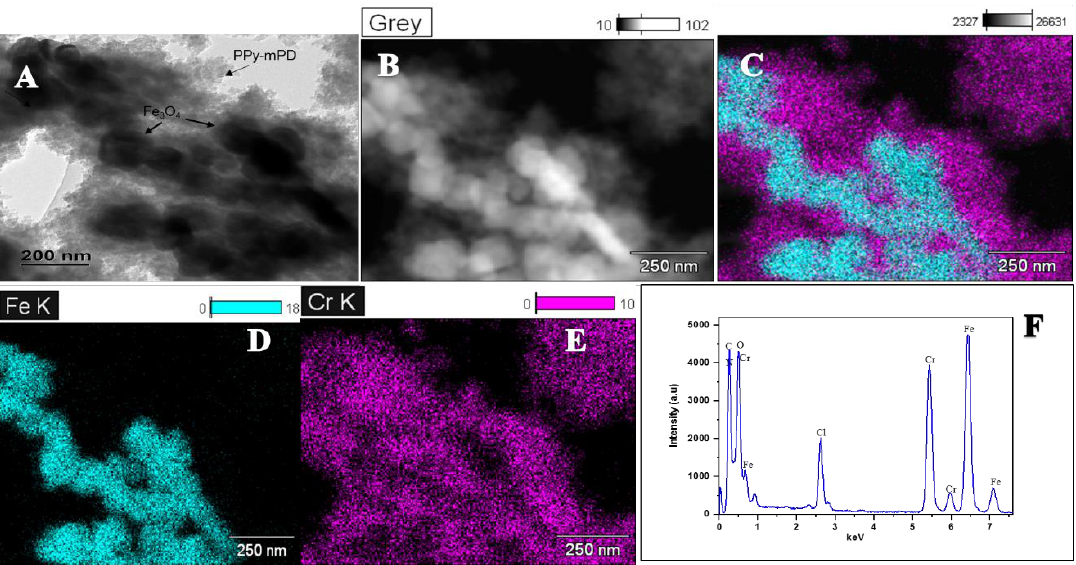
Figure 2. ( A ) HR-TEM images, ( B – E ) elemental mapping images, and electron diffraction X-ray scattering (EDX) spectra ( F ) of the PPy– m PD/Fe 3 O 4 nanocomposite after Cr(VI) adsorption.